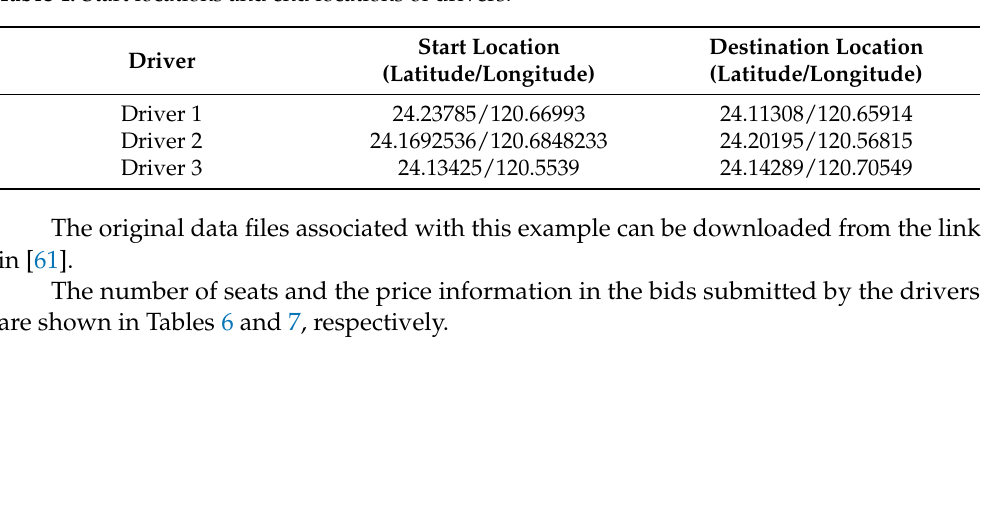
Table 4. Start locations and end locations of